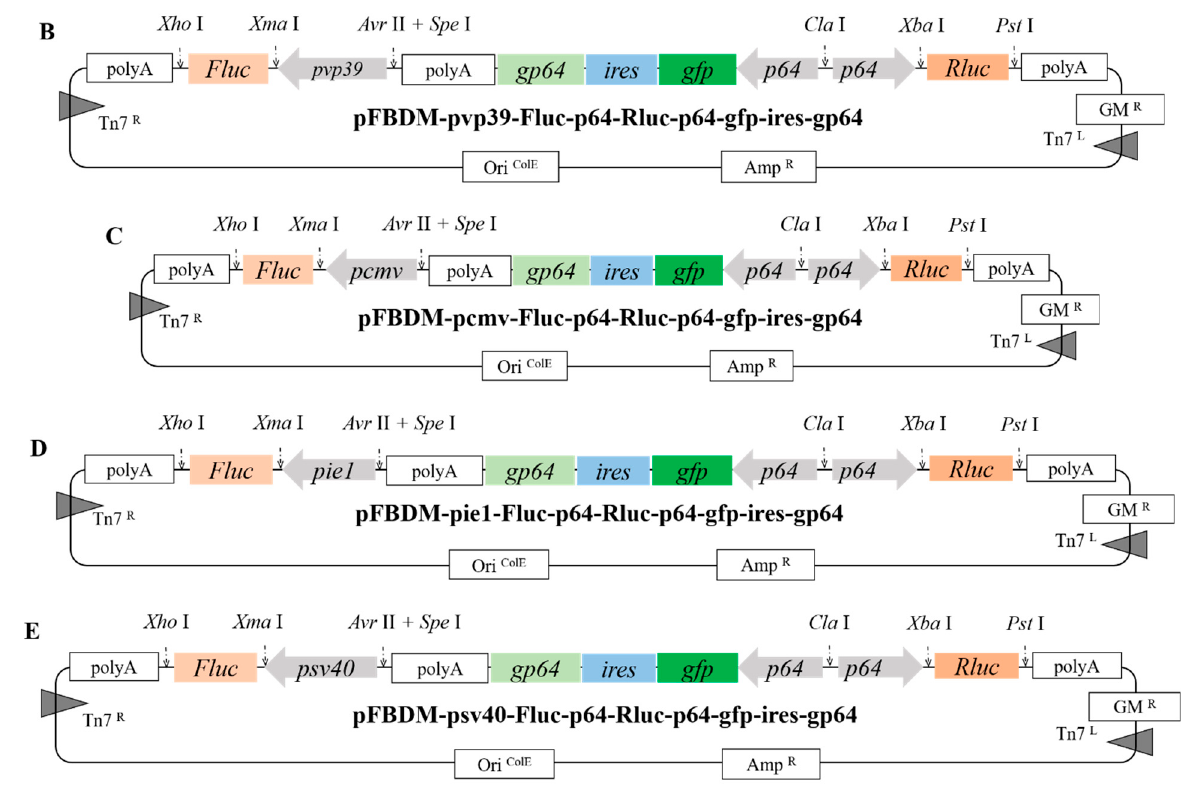
Figure 1. Construction of recombinant plasmid pFBDM carrying different promoters ( p10 , pvp39 , pcmv , psv40 , and pie1 ). The gene expression cassette p64-Rluc-polyA was used for the expression of the Renilla luciferase (as reference). The cassette p64-gfp-ires-gp64-polyA could express GP64 in low-expression as compensation for gp64 -deficient Bacmid. Different promoters in the cassette pX- Fluc-polyA (pX: p10 , pvp39 , pcmv , pie1 , and psv40 ) mediate the expression of Firefly luciferase. ( A – E )